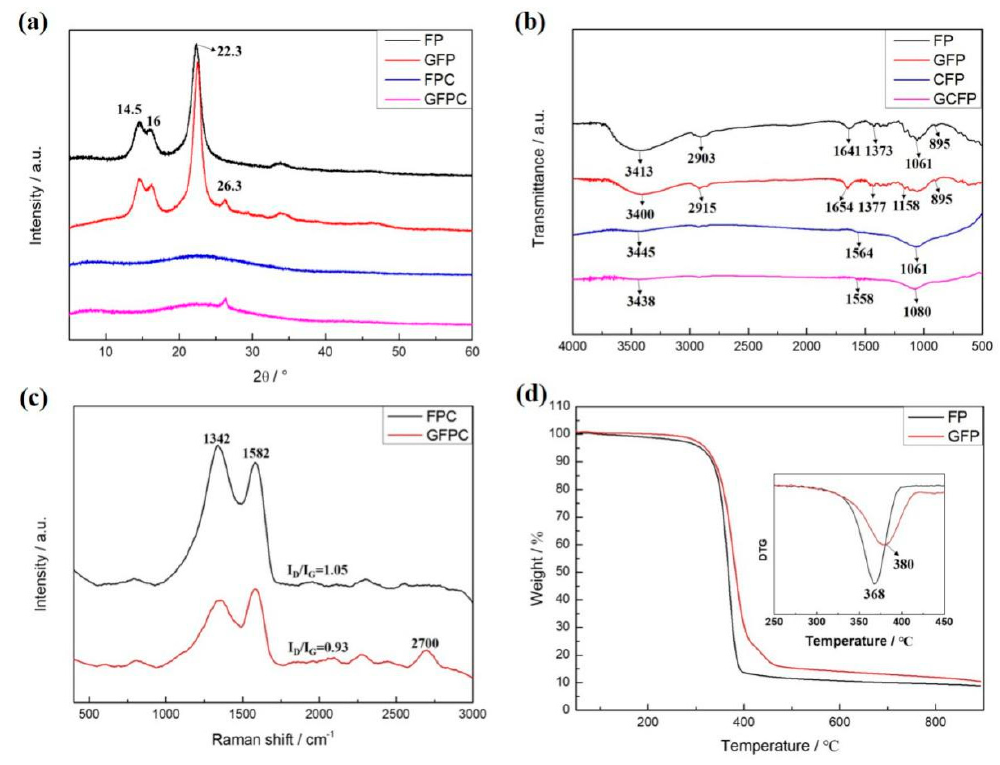
Figure 4. ( a ) XRD pattern, ( b ) FT ‐ IR pattern, ( c ) Raman spectra, ( d ) TGA of FP and GFP. Inset in ( d ) is DTG of FP and GFP.